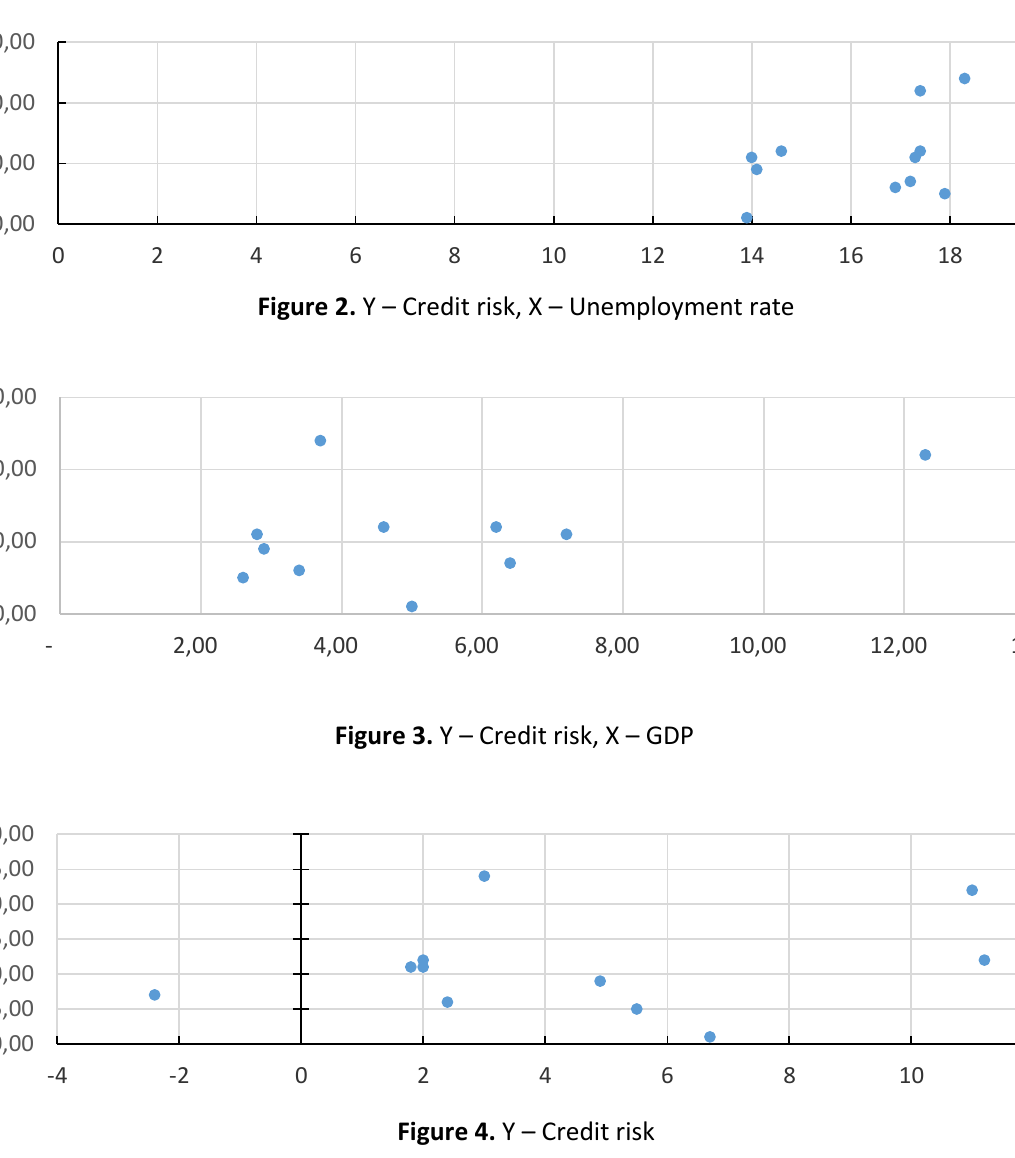
Figure 1. Credit risk of the Bank of Georgia (overdue credit 90+)